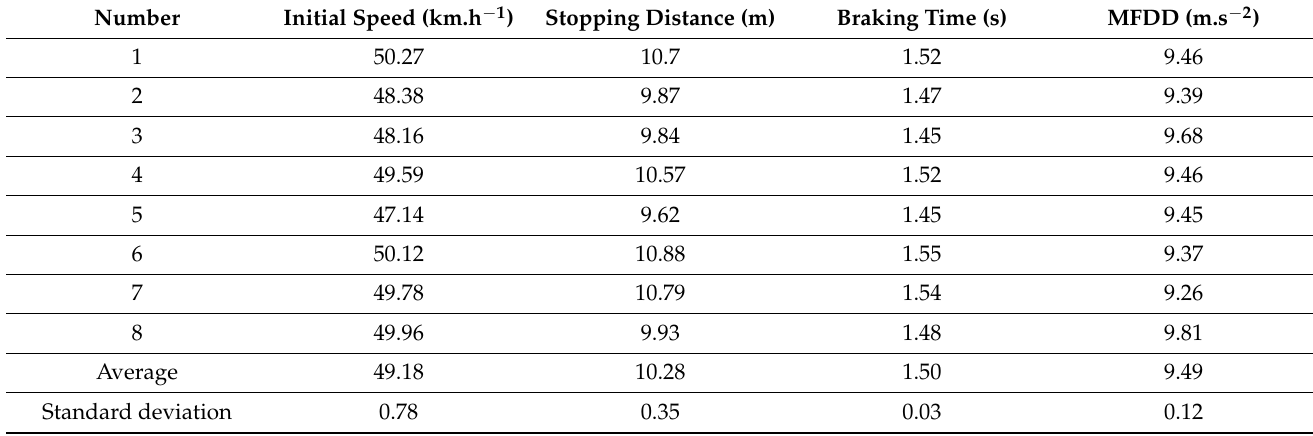
Table 10. Braking characteristics measured with mid-priced brake